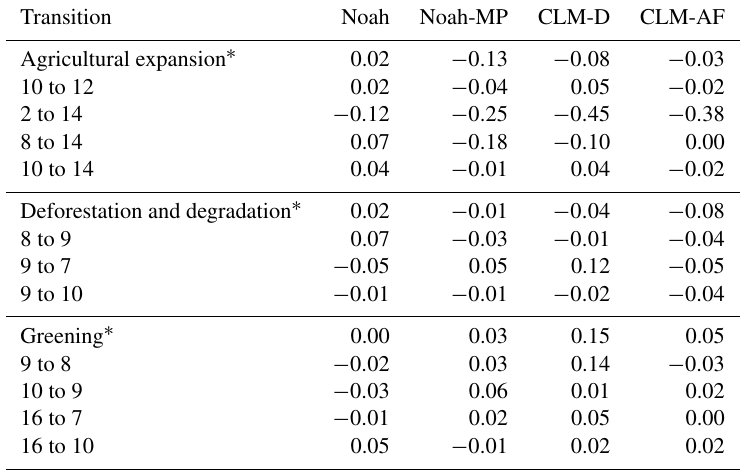
Table 11. Annual average precipitation rate change (mmd − 1 ) in WRF grid cells that experience LULCCs between 2001 and 2015. Transition Noah Noah-MP CLM-D CLM-AF